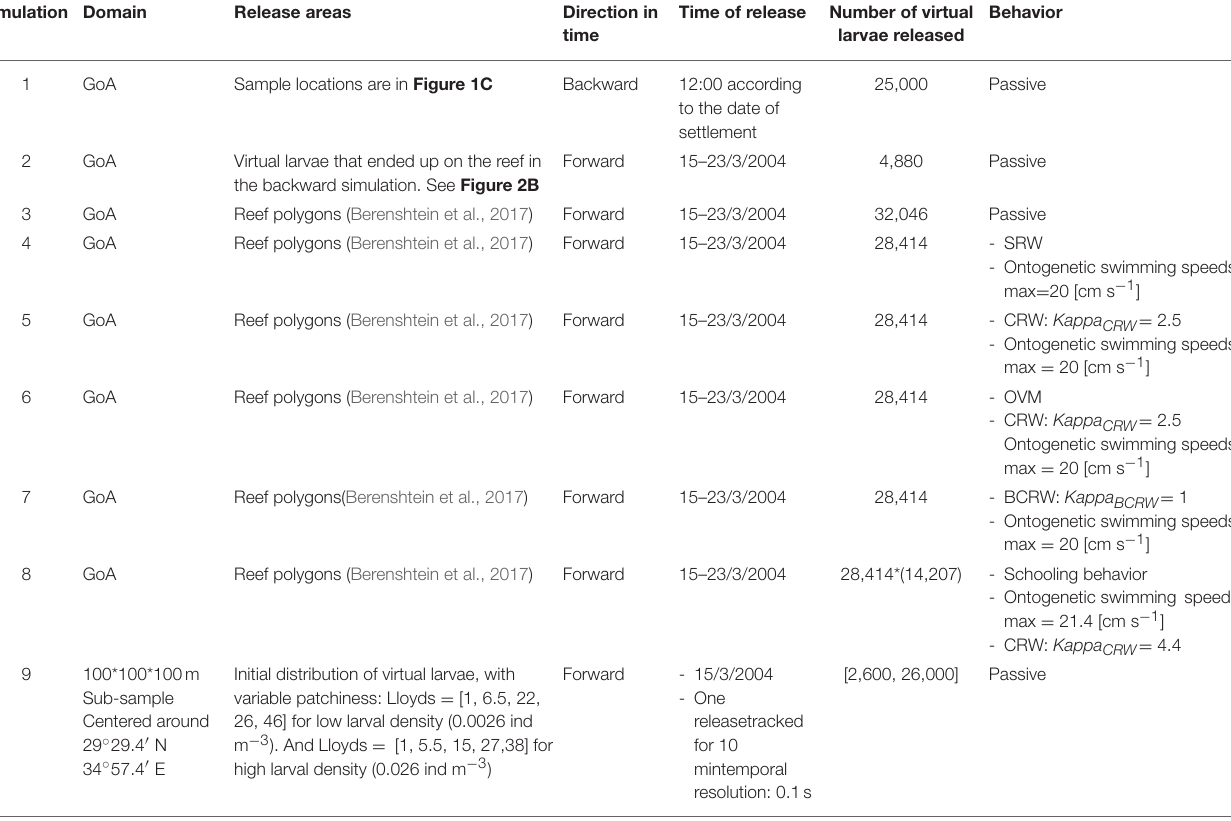
TABLE 1 | Biophysical simulations scenarios- model configuration and behavior of virtual larvae. Simulation